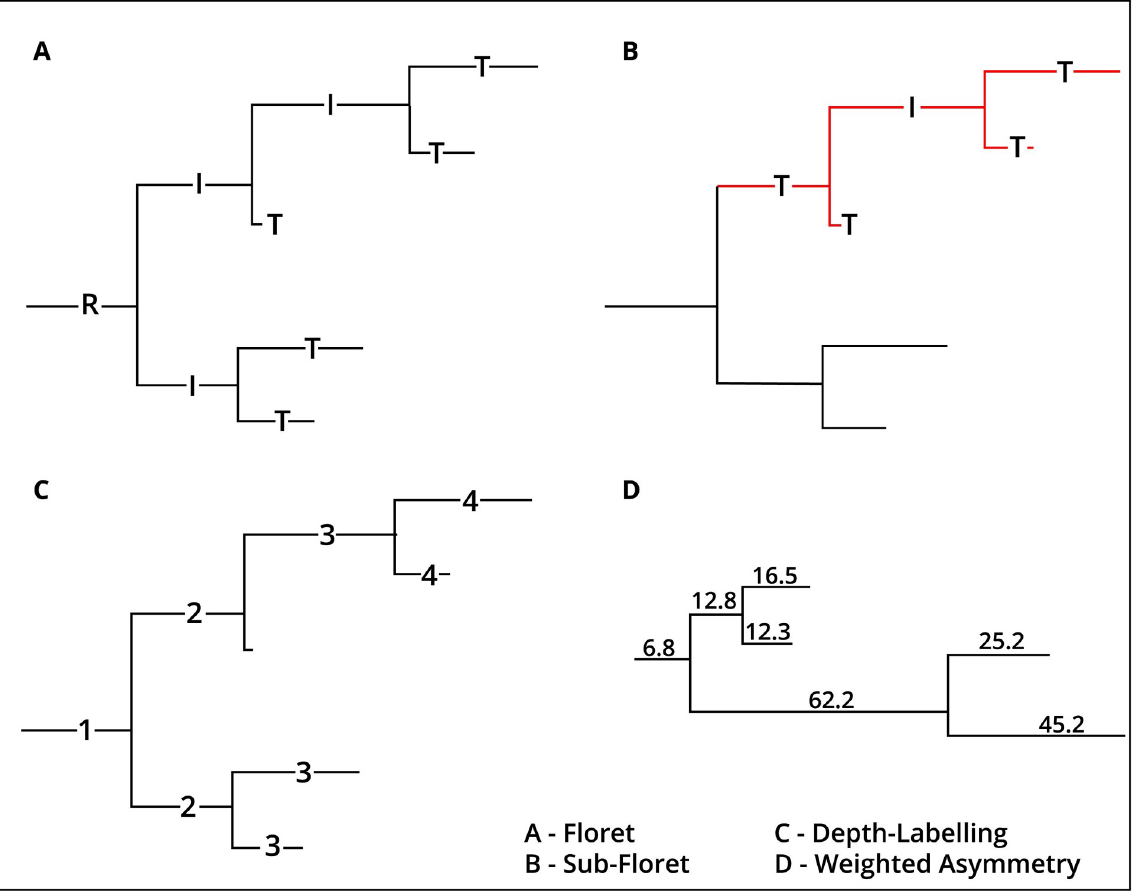
Fig 2. Visualization of axonal arbors with dendrograms. The indicators employed for evaluation of florets can be fully represented by dendrograms. (A) The dendrogram of a floret together with the different types of segments: Terminal segments (”T”), the root segment (“R”) and the internal segments (“I”). (B) An exemplary sub-floret is shown in red. (C) Each segment labeled by its depth. While the root segment has depth one, each subsequent bifurcation increments the depth by one unit. (D) For this floret from the dataset, the number of segments are identical for left and right sub-florets, the respective lengths, however, differ. Accordingly, the floret is perfectly symmetrical according to Van Pelt’s asymmetry index (asymmetry index = 0), but has an asymmetry of 0.41 according to the length-weighted asymmetry index.